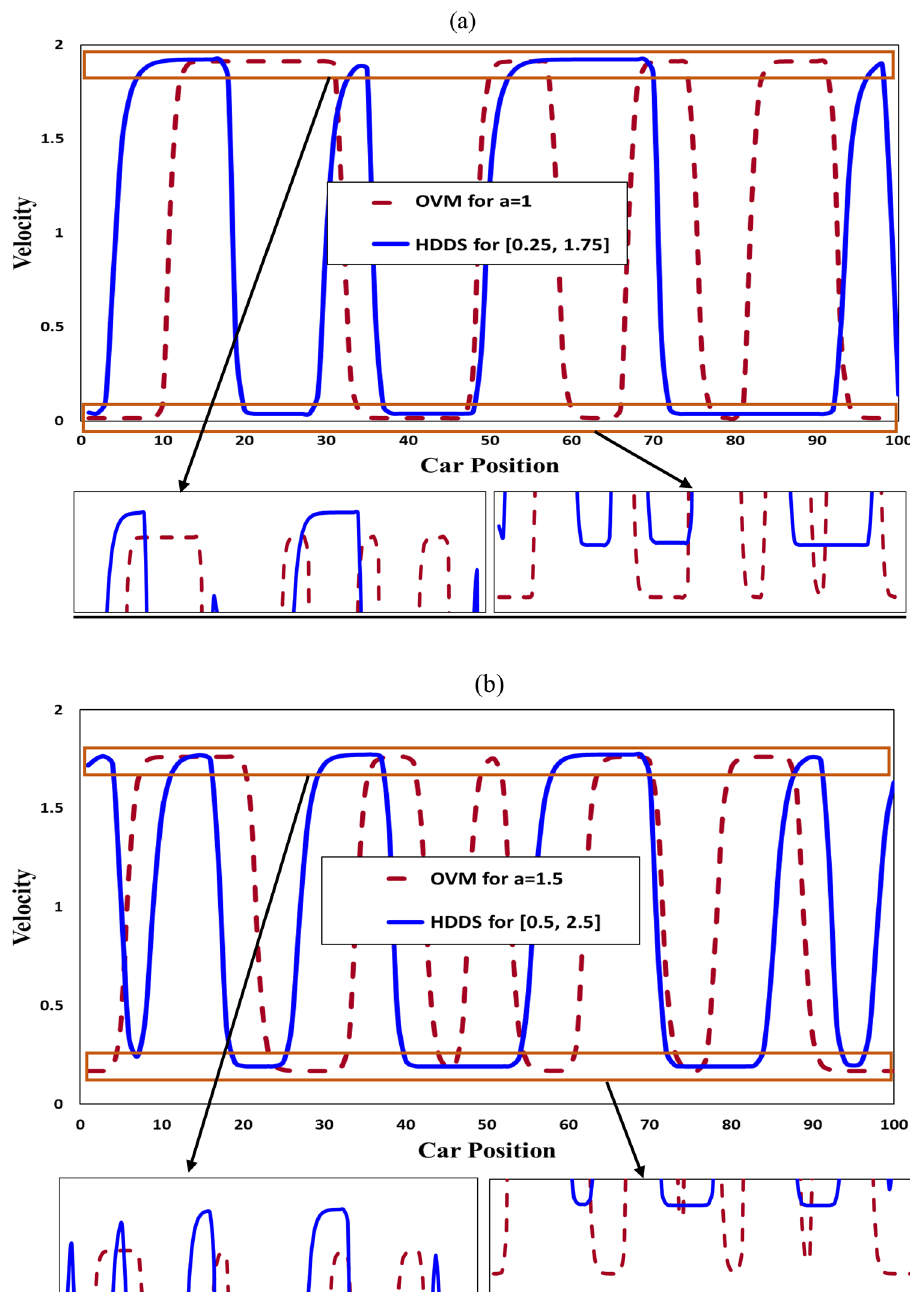
Figure 6. Comparison analysis of velocity profile of all vehicles at a particular time step, t = 100,000, for the HDDS and conventional OV models. The panels show the results for ( a ) OV model a = 1 where HDDS model a avg = a max + a min 2 = 1 and ( b ) OV model a = 1.5 where HDDS model a avg = a max + a min 2 = 1.5